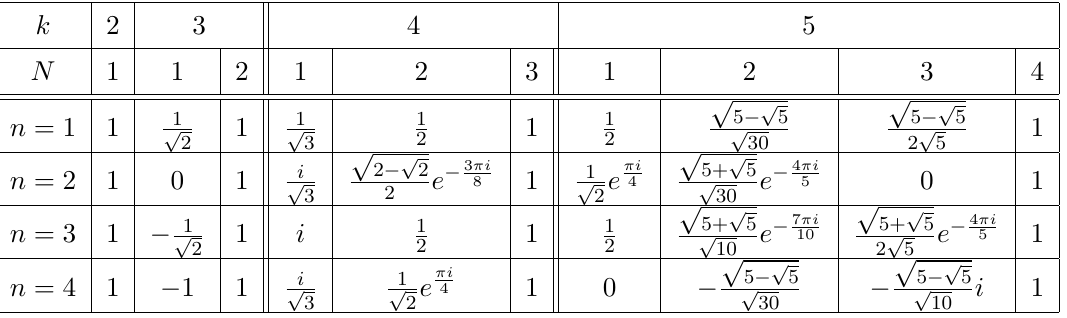
Table 7 . The exact values of the both side of (4.12) for 2 ≤ k ≤ 5 , 1 ≤ N ≤ k − 1 and 1 ≤ n ≤ 4 with b = 1